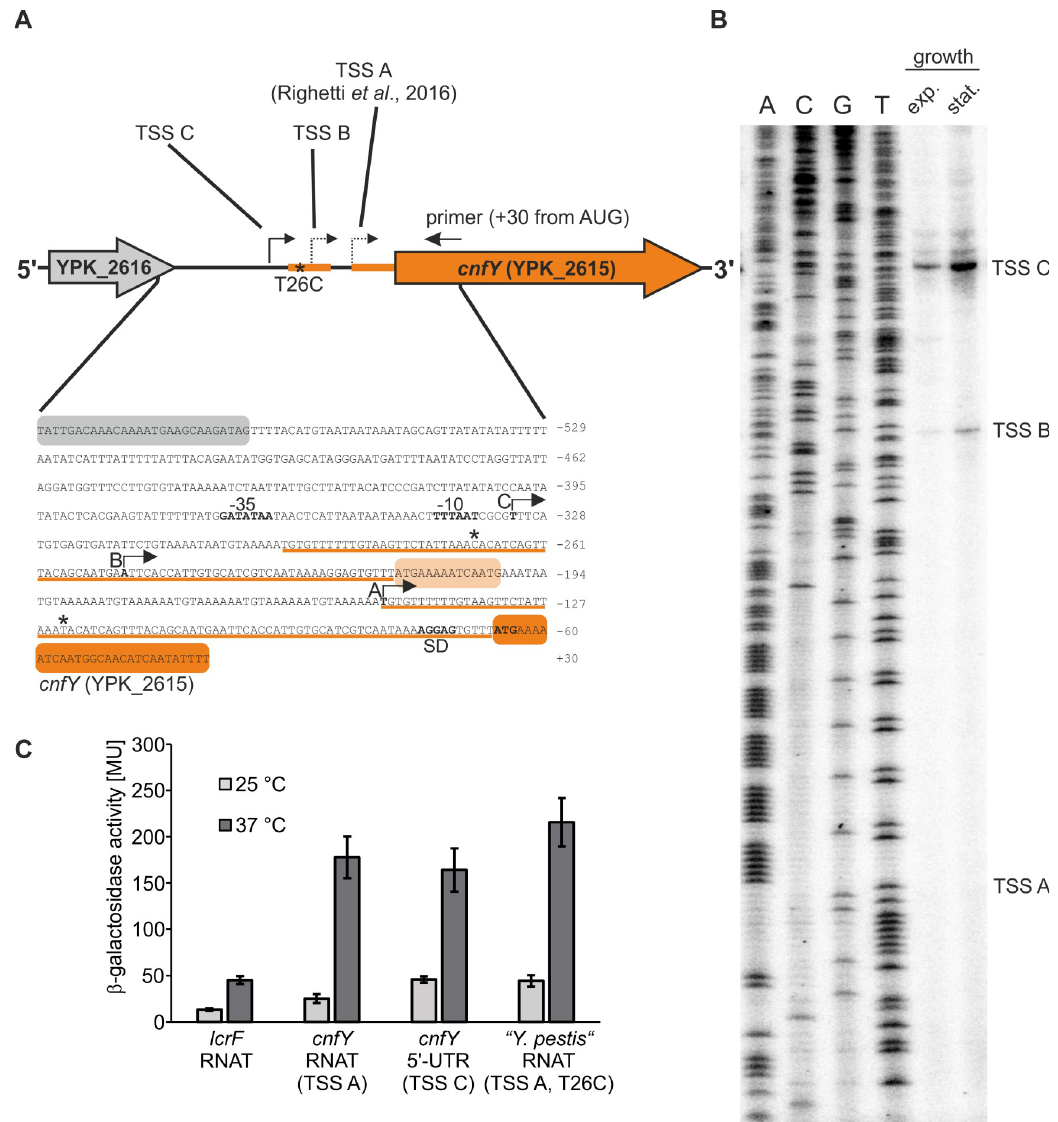
Fig 2. The cnfY RNAT functions regardless of the transcriptional site. (A) Schematic representation of the cnfY (YPK_2615) gene locus. Transcriptional start sites (TSS) identified in a previous study [18] and in this study are marked by arrows. Additionally, the sequence of the intergenic region between YPK_2616 (coding for a putative transposase) and cnfY is displayed. The underlined sequences (orange line) represent the duplicated RNAT sequences. The sequence variation T26C observed in the duplicated sequences is marked by asterisks. (B) Identification of cnfY TSSs by primer extension. Total RNA was isolated from a Y . pseudotuberculosis YPIII culture grown at 37˚C to exponential (OD 600 = 0.5) and stationary growth phase (OD 600 = 1.5). Primer extension was performed using a radiolabeled primer (binding is shown in A). The cDNA products were separated via polyacrylamide gel electrophoresis. The experiment was conducted in three biological replicates. (C) Y . pseudotuberculosis cnfY 5’- UTRs (+30 nt of the coding region; pBO3192, pBO6527) and the Y . pestis cnfY RNAT (-82 nt to +30 nt from AUG; pBO6523) were translationally fused to bgaB and tested for β -galactosidase activity. The lcrF RNAT was used as positive control (pBO3146). E . coli DH5 α cells harboring the corresponding plasmid (technical triplicate per each construct) were grown to an OD 600 = 0.5 at 25˚C. Afterwards, transcription was induced with 0.01% (w/v) L-arabinose and the culture was split. One half remained at 25˚C while the other was transferred into pre-warmed flasks (37˚C). After 30 min of incubation, samples were taken for subsequent β - galactosidase assay. The displayed results represent the mean activities from three independent experiments (biological replicates). Mean standard deviations are indicated as error bars.